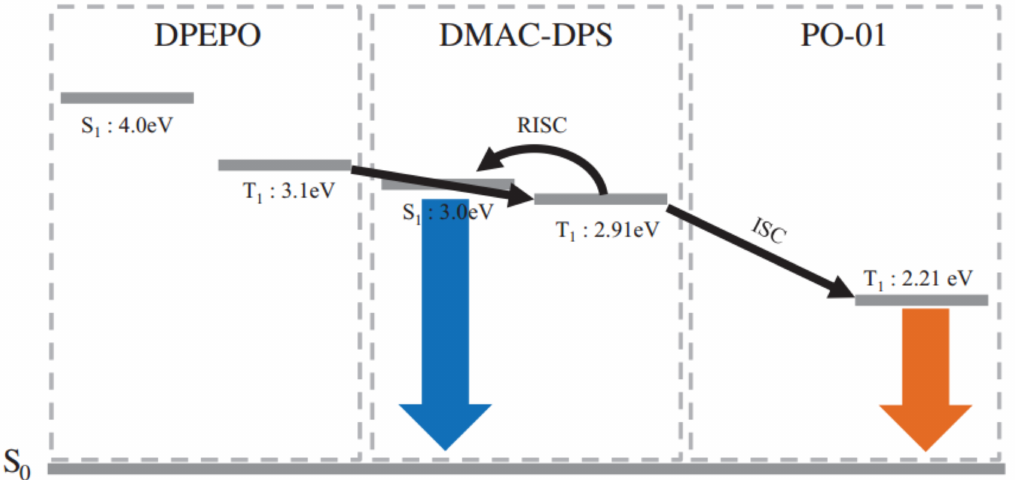
Figure 12. Schematic diagram showing the energy transfer process of the white EML. Reproduced with permission from [156], IOP Publishing,